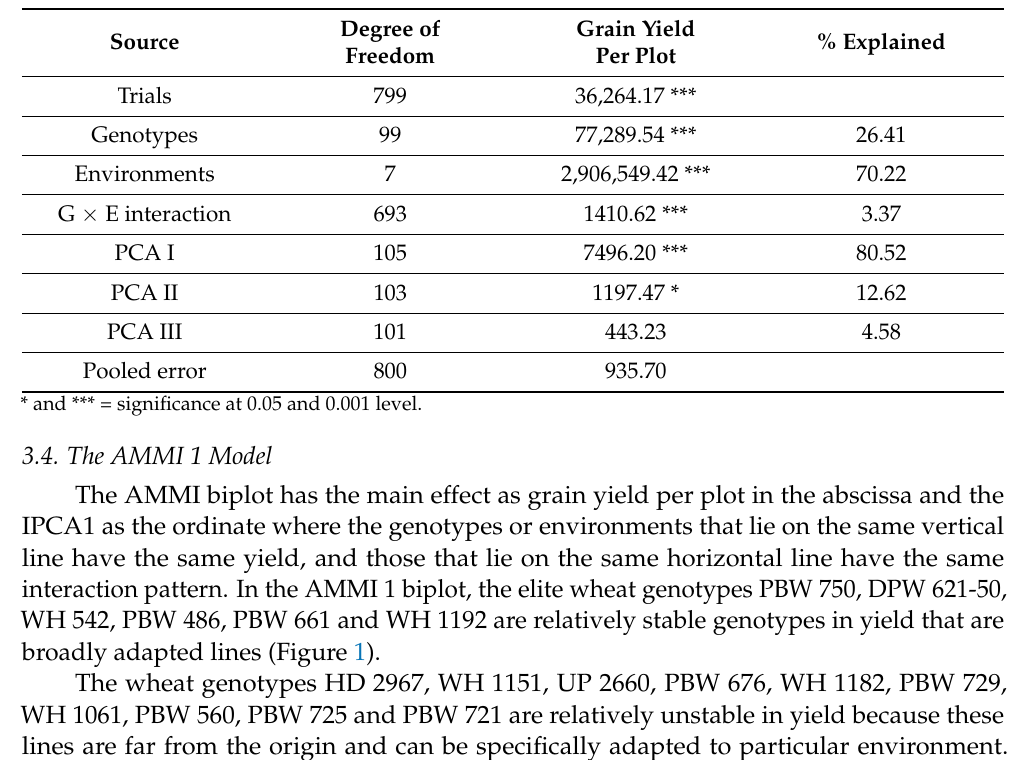
Table 8. Pooled analysis of variance for grain yield per plot of 100 wheat genotypes across different environments using AMMI